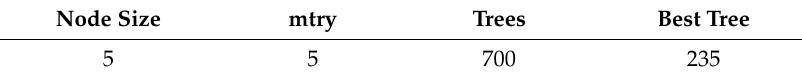
Table 4. Extracting best parameters in Rf model.